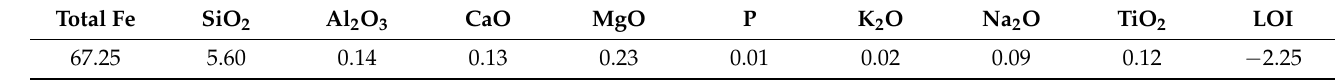
Table 1. Main chemical composition of magnetite concentrate (wt.%).